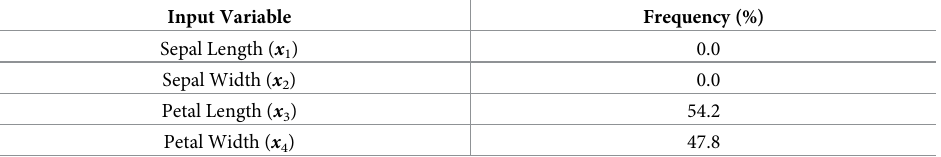
Table 4. Feature-ranking of the Iris dataset, according to our proposed optimally-separating